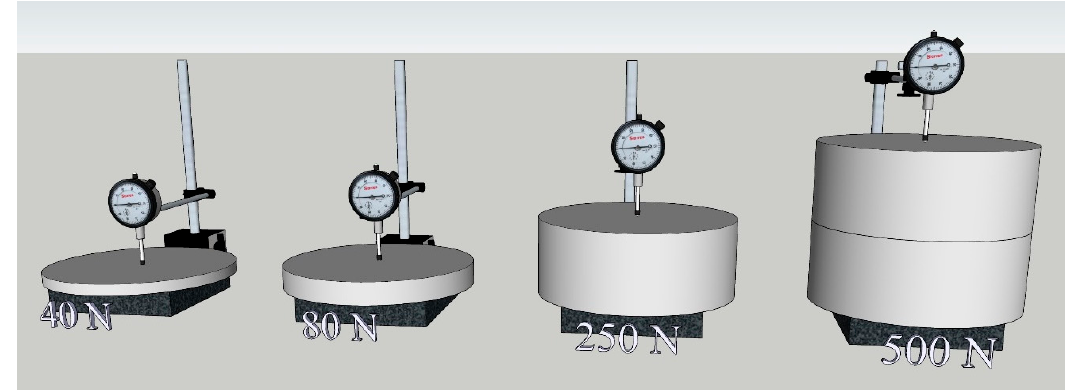
Figure 2. Test setup for deflection of the resilient materials.